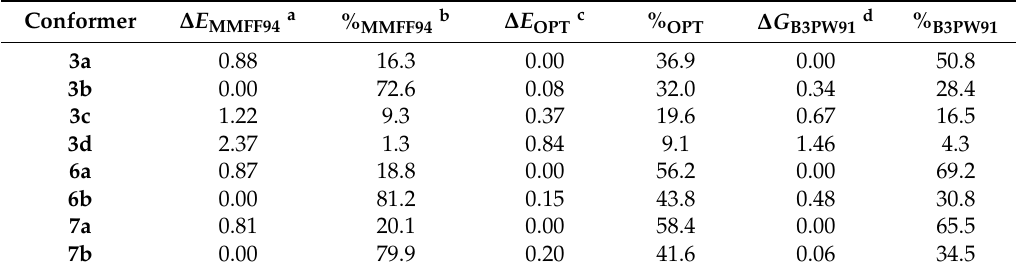
Table 4. Relative energies and conformational populations of 3 , 6 , and 7